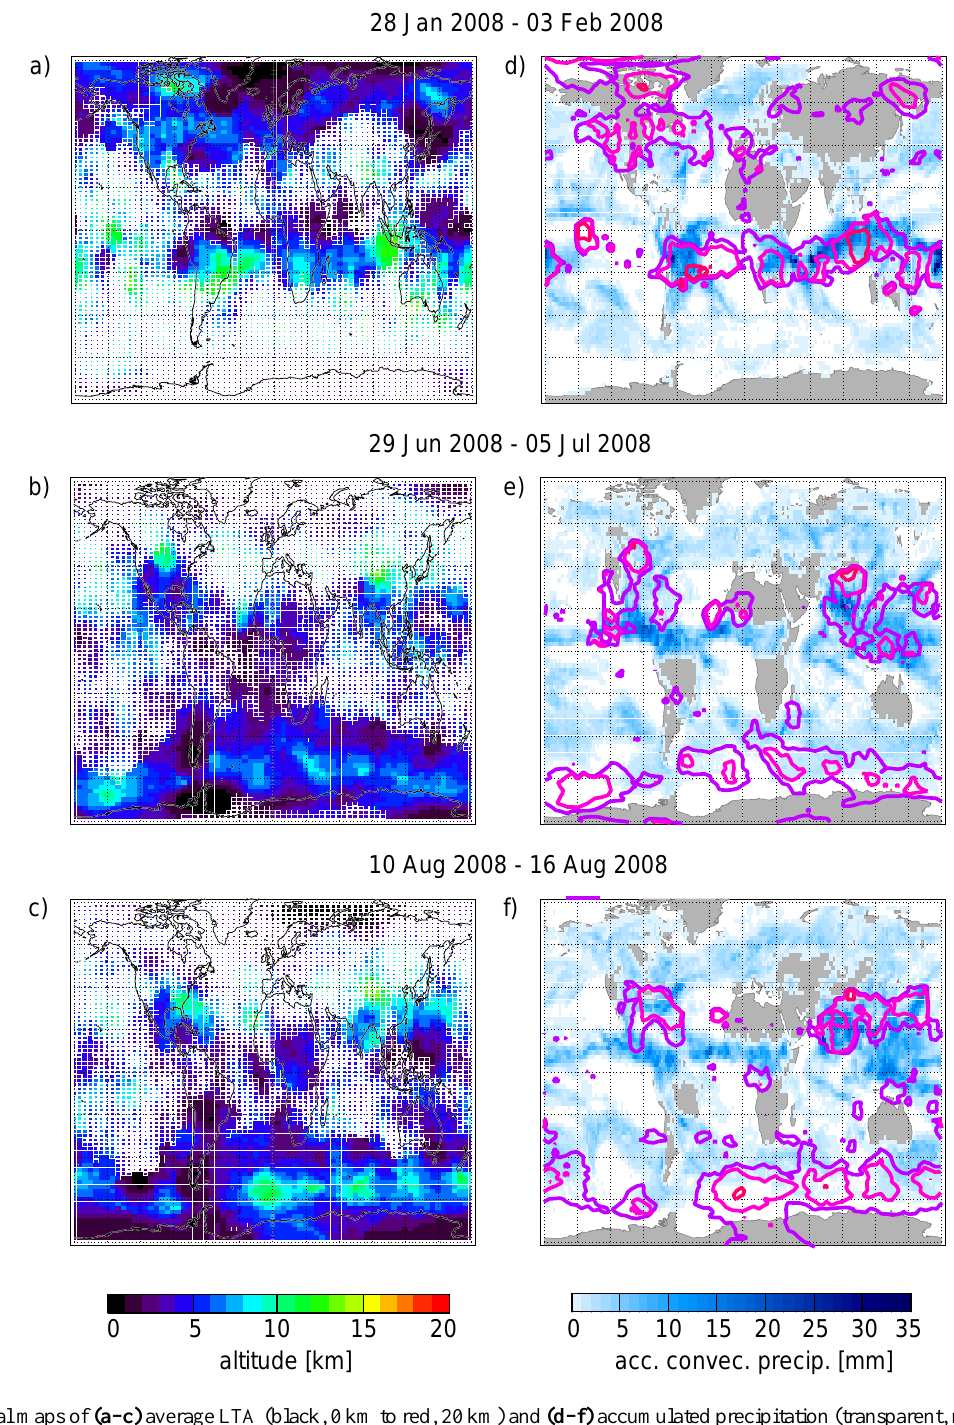
Figure 5. Global maps of (a–c) average LTA (black, 0km to red, 20km) and (d–f) accumulated precipitation (transparent, no precipitation to dark blue, 35mmday − 1 ) for three 1-week periods in January/February (upper row), June/July (middle row) and August 2008 (lower row). Precipitation is smoothed by a box-average of 9 × 9 points. For (a) , (b) and (a) the length of the rectangles is proportional to the accumulated GWMF for circular source regions of π 800 2 km 2 : the length equals the sampling distance for GWMF of 30mPa (for details see text). Also shown in the right column by contours are average LTA of 5km (purple), 7km (pink) and 11km (red) only for those regions where accumulated GWMF exceeds 20 mPa.